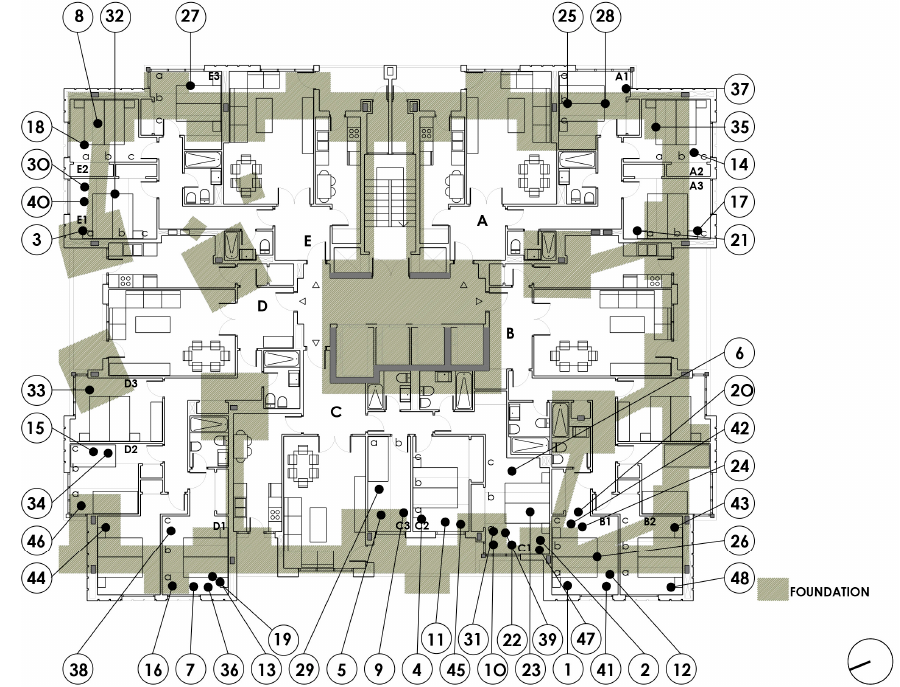
Figure 10. Floor plan dwellings type 1 to 16. Overlapping foundation. Figure 10 . Floor plan dwellings type 1 to 16. Overlapping foundation.